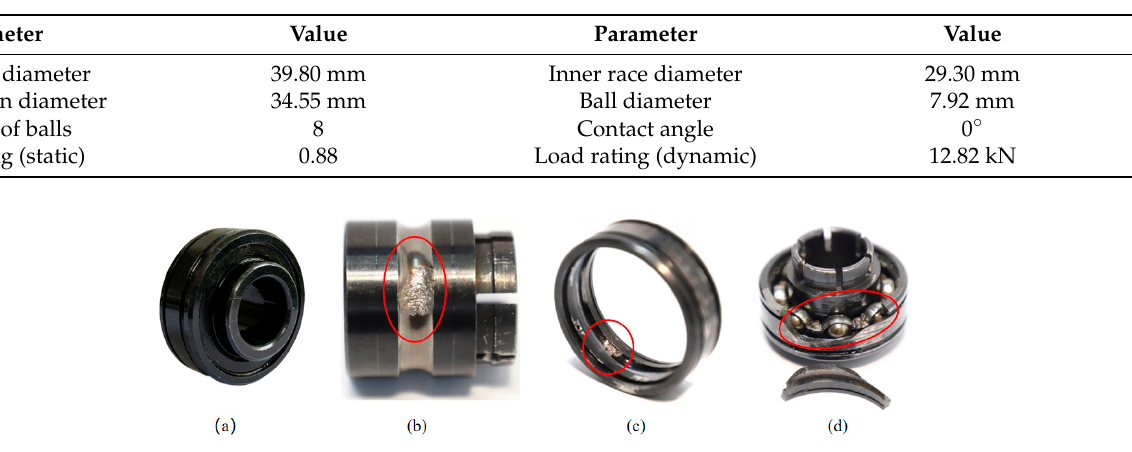
Table 6. Parameters of the tested bearings.